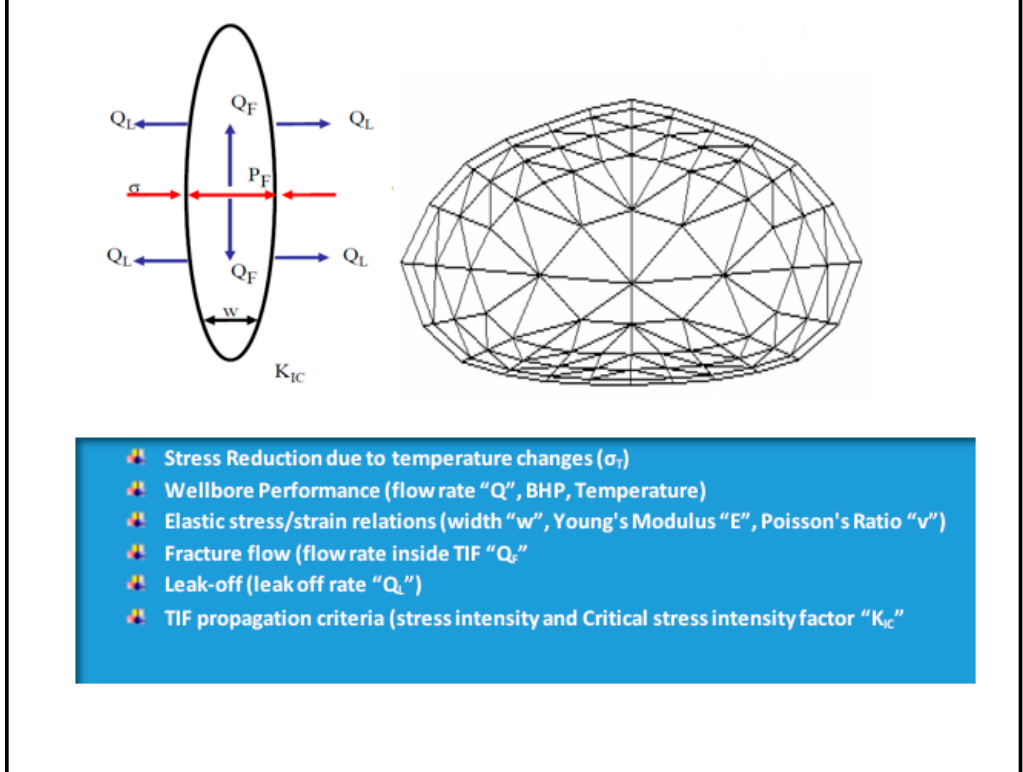
Figure 11. Various relationships involved in a TIF model [4].